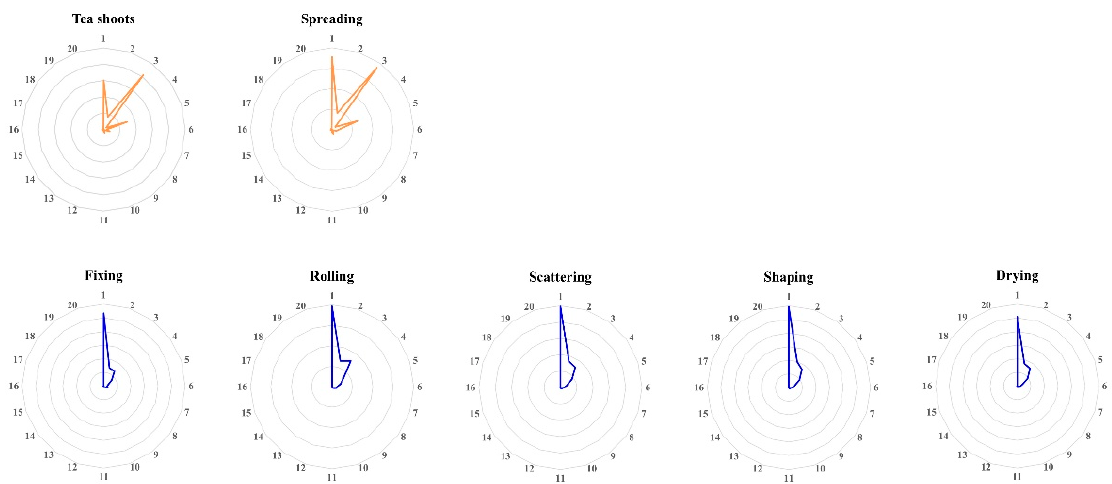
Figure 8. Aroma shape of the processed XYMJ green tea samples based on the top twenty odorants with high OAVs, namely trans-nerolidol (1), geranylacetone (2), nonanal (3), (+)- δ -cadinene (4), linalool (5), (Z)-jasmone (6), cis-3-hexenyl butyrate (7), cis-3-hexenyl hexanoate (8), methyl jasmonate (9), β -ocimene (10), β -myrcene (11), copaene (12), cis- β -farnesene (13), D-limonene (14), (E)- β -ocimene (15), dihydroactinolide (16), M-cymene (17), (Z,E)- α -farnesene (18), methyl salicylate (19), and geranial (20).